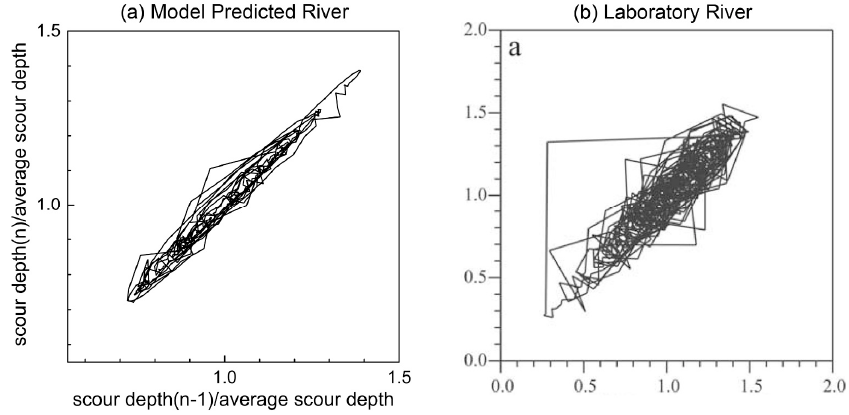
Figure 10. State-space plots for ( a ) the model-predicted river and ( b ) a laboratory river.